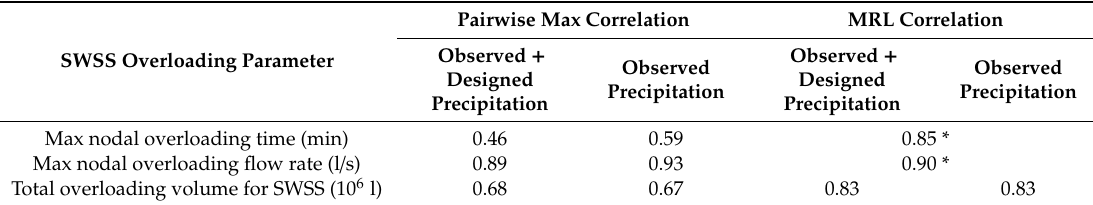
Table 10. Comparison of pairwise and multi-linear regression Pearson’s